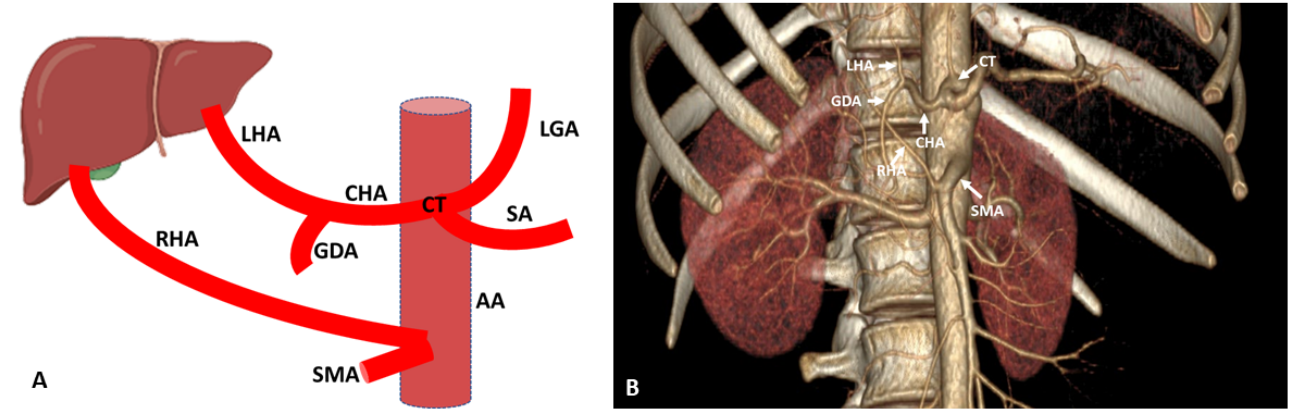
Figure 4. ( A ) Schematic representation of aberrant (replace) RHA originated from SMA. ( B ) Three- dimensional (3D)-VR image (64 row CT-angiography) of the abdominal region showing aberrant (replaced) RHA originated from SMA. AA: Abdominal aorta; CT: Celiac trunk; SA: Splenic artery; LGA: Left gastric artery; CHA: Common hepatic artery; RHA: Right hepatic artery; LHA: Left he- patic artery; GDA: Gastroduodenal artery; SMA: Superior mesenteric artery.